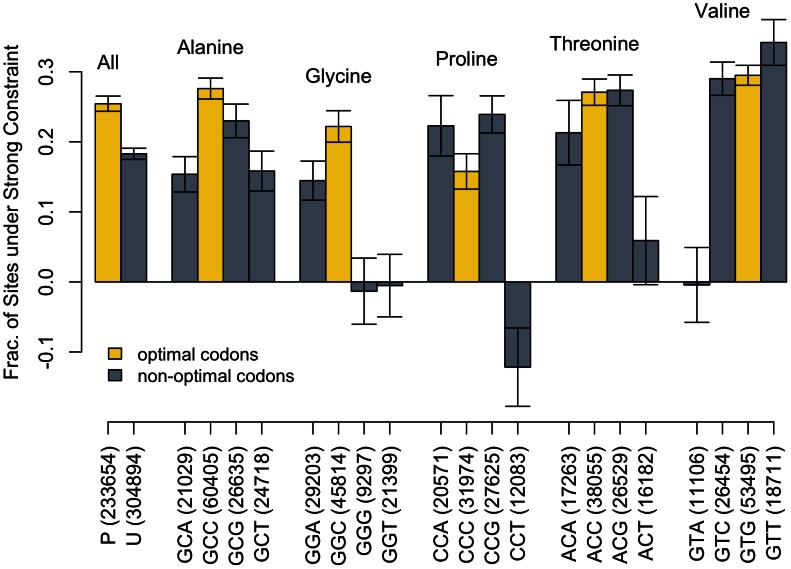
Constraint across codons.For each amino acid, we list the codons and, in parentheses, the number of 4D sites from each codon used in the bootstrap analysis – representing, in relative terms, the abundance of each codon in the genome. P-codons are all 4D sites from optimal codons grouped together, while U-codons are all 4D sites from non-optimal codons. 4D sites were binned into codons either by their ancestral allele as determined by parsimony to D. sechellia or by major allele if there is a substitution at that site between D. sechellia and D. melanogaster. Gold bars are the optimal codons for each amino acid, while dark grey bars are the non-optimal codons. 10 bootstraps determine the fraction of sites under constraint for each codon-type. Error bars represent the s.e. of the estimates. A negative value indicates an excess of polymorphism at 4D sites compared to short introns and is likely due to mispolarization assigning SNPs to the wrong codon.